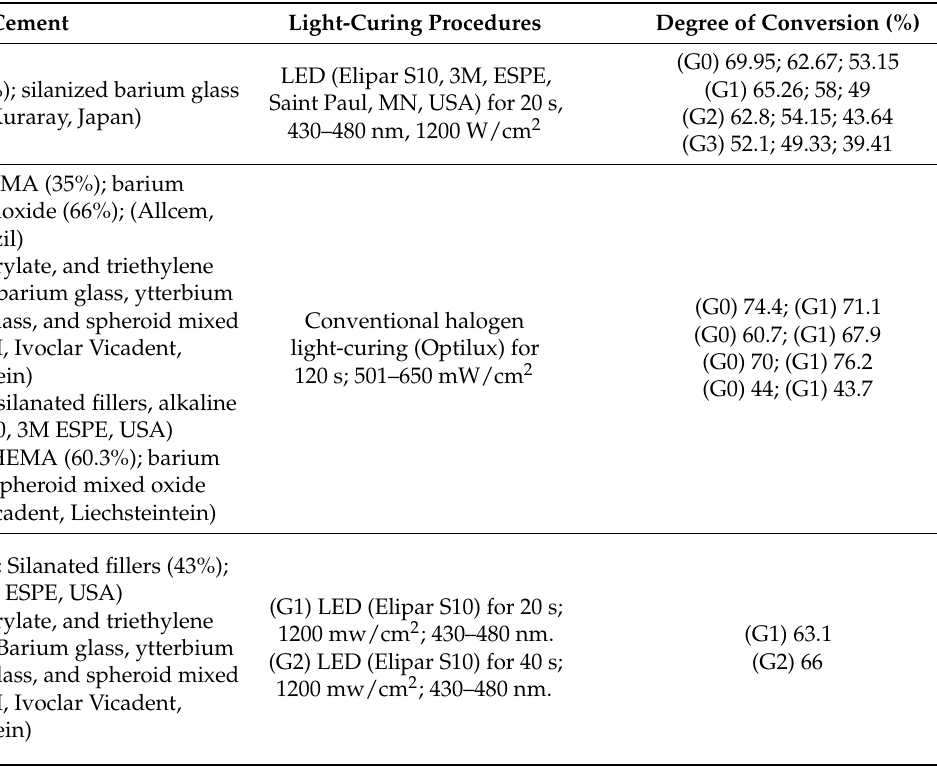
Table 1. Relevant data retrieved from previous studies on resin-matrix cements and their degree of